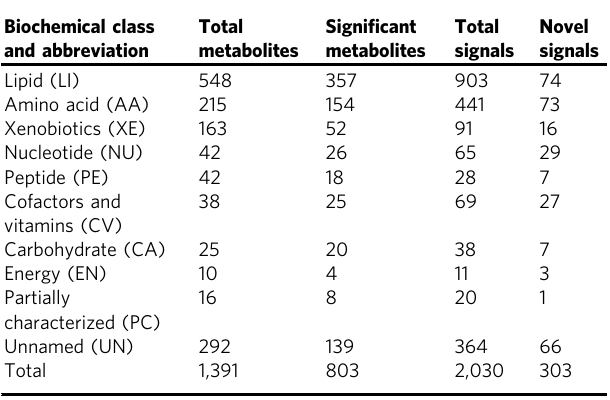
Table 1 Summary of the 2030 genetic association signals by metabolite biochemical